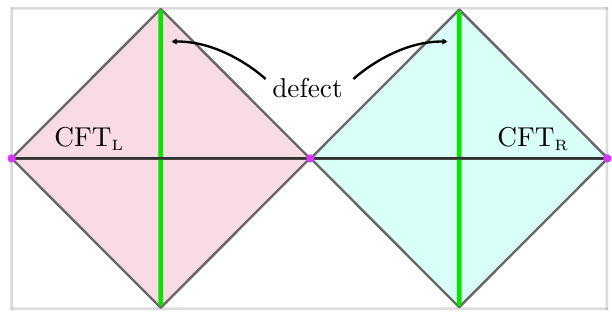
Figure 7. Conformal defects along a CFT bath in the boundary perspective